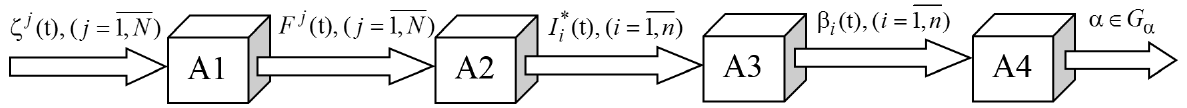
Figure 4. Structural and logical scheme of the algorithm for solving the problem of parametric synthesis Block A1 is the generator of a random vector